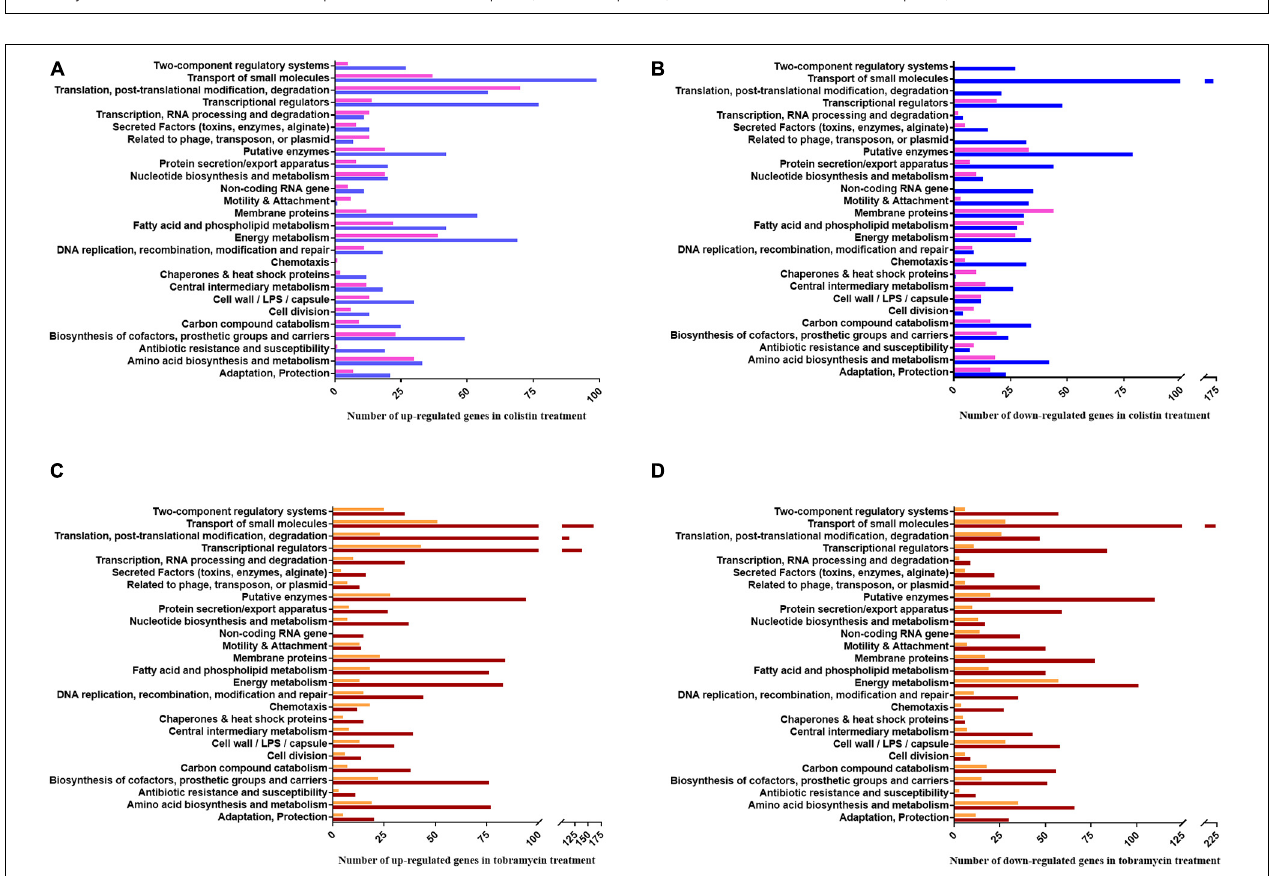
FIGURE 3 | Scatter plots showing the correlation between gene expression fold-changes in RNA-seq and Ribo-seq data obtained after (A) colistin treatment and (B) tobramycin treatment. The X -axis corresponds to the RNA-seq data, or transcriptome, and the Y -axis to the Ribo-seq data, or translatome.